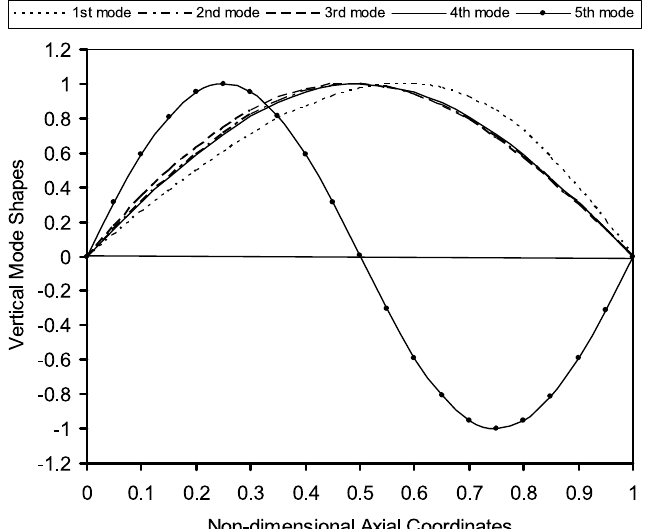
Fig. 4. The fi rst fi ve mode shapes for the second case.